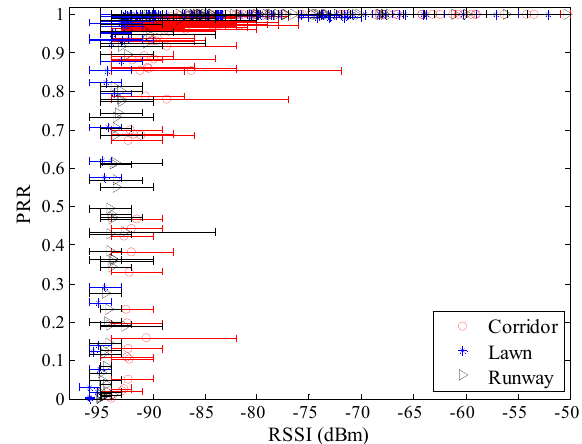
Figure 7. Received Signal Strength Indicator ( RSSI ) vs. PRR in different environments.